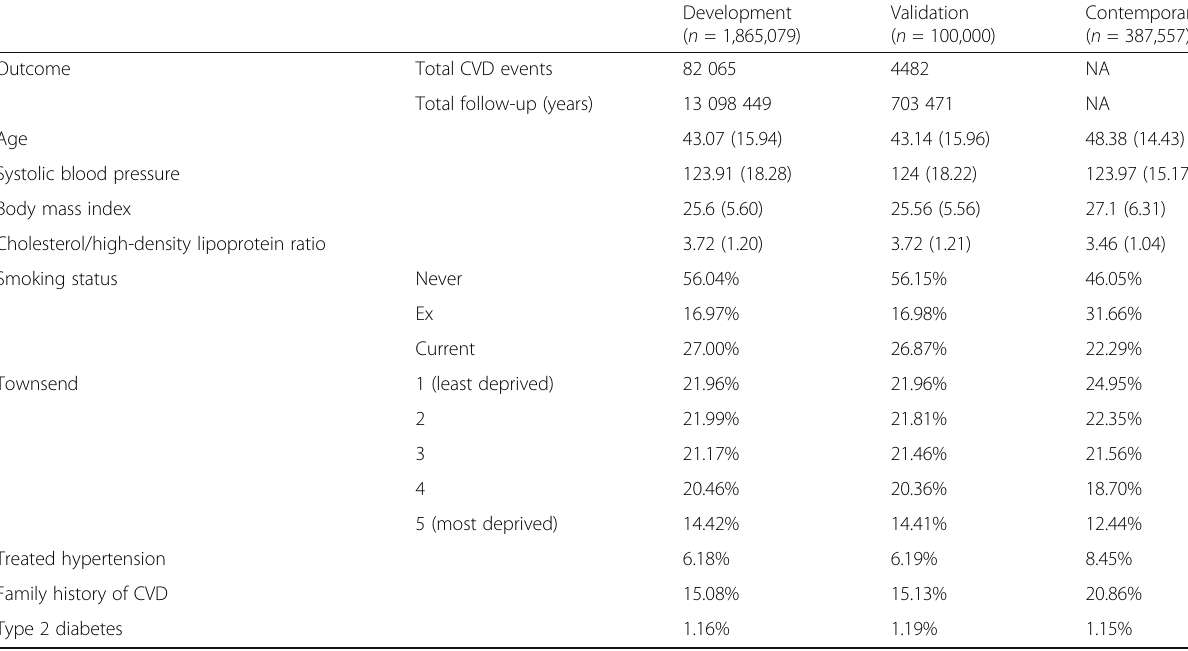
Table 1 Baseline characteristics of each female